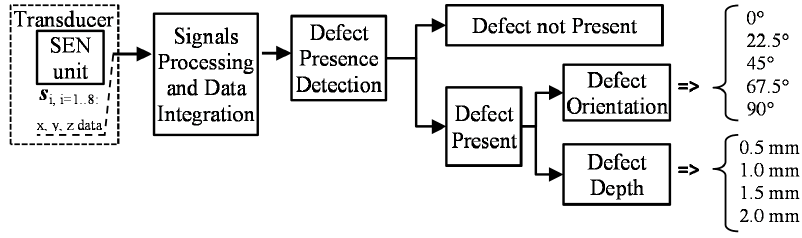
Figure 8. The block diagram of multi-class defect evaluation procedure from single point measurements.